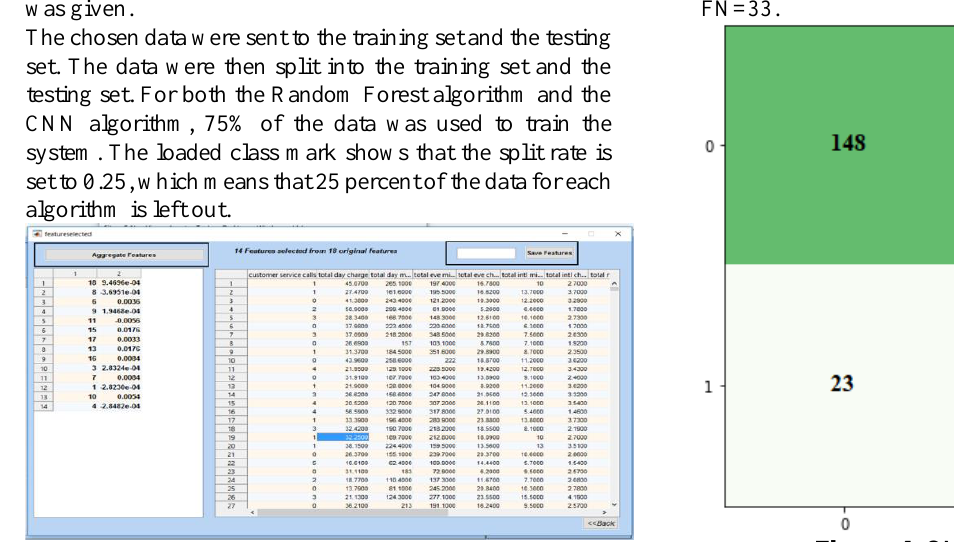
Figure 3. Selected Features Using Relief-F Algorithm Figure 4. CNN Confusion